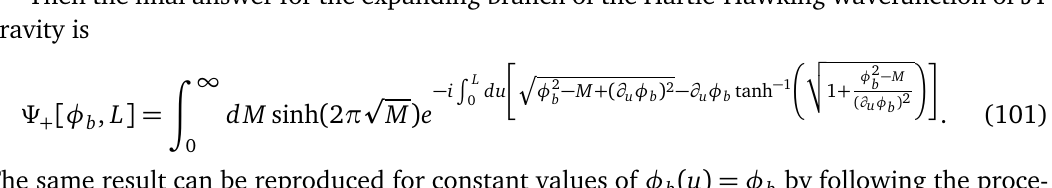
Figure 3: Frame in which geometry is rigid dS curve where we compute the wavefunction in blue (defined by its length and dilaton